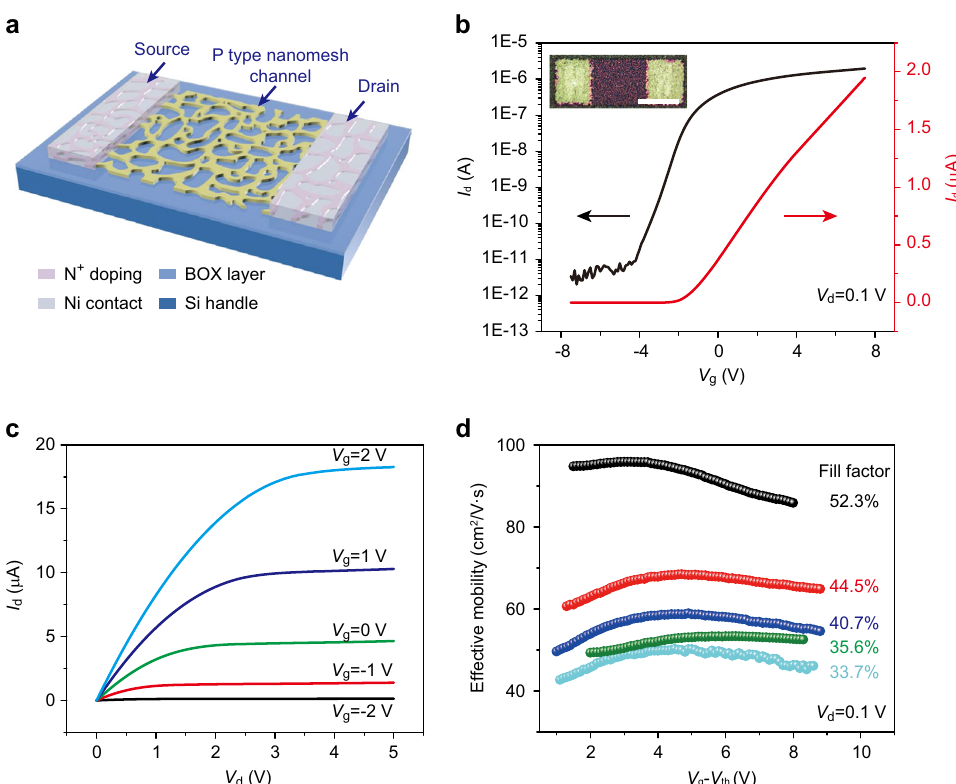
Fig. 2 Carrier transport properties of Si nanomeshes. a Schematic of a Si nanomesh transistor. The device is fabricated on an SOI wafer with 100-nm-thick Ni as the source-drain contact, a 120-nm-thick buried SiO 2 layer as the dielectric, and Si handle wafer as the global back gate. b Transfer characteristics of the Si-nanomesh transistor with 52.3% fi ll factor on a log scale (left y-axis) and a linear scale (right y -axis) at a drain voltage of 0.1 V. The channel width and length are 35 μ m and 40 μ m, respectively. The inset is the optical image of the as-fabricated device. The scale bar is 20 μ m. c Output characteristics of the same device shown in b at gate voltage steps from − 2 V (bottom) to 2 V (top). d Extracted effective mobility from transistors of nanomeshes with different Si fi ll factors as a function of gate